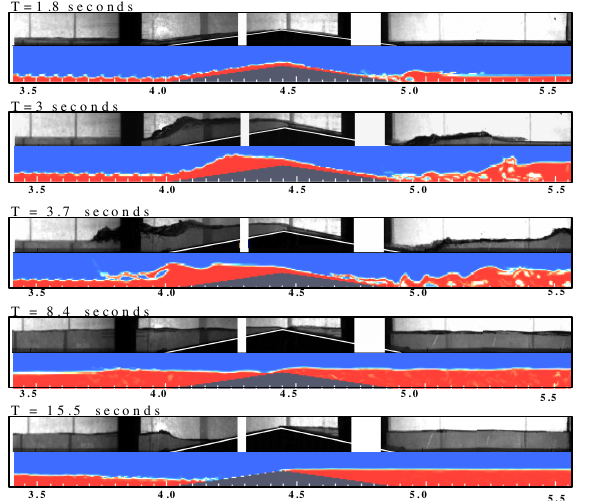
Fig. 13. Comparison between three-dimensional model results (bot- tom) and pictures of the experiment (top).